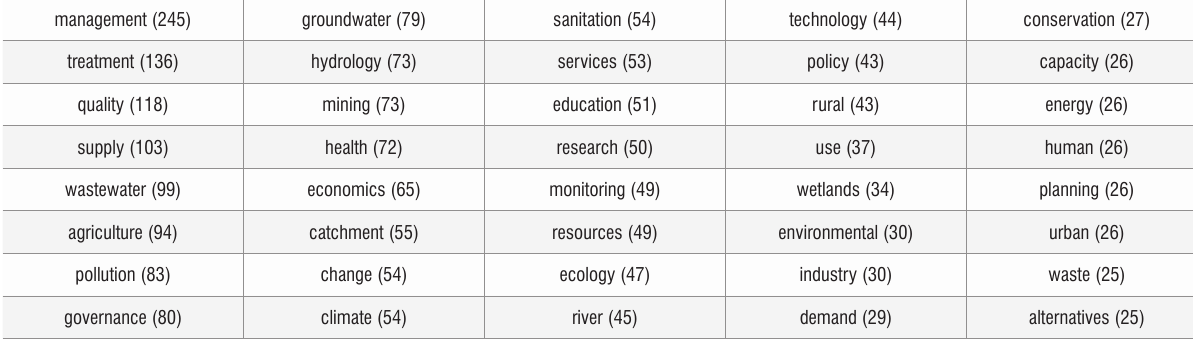
Table 1 : Top 40 research questions by keyword provided by